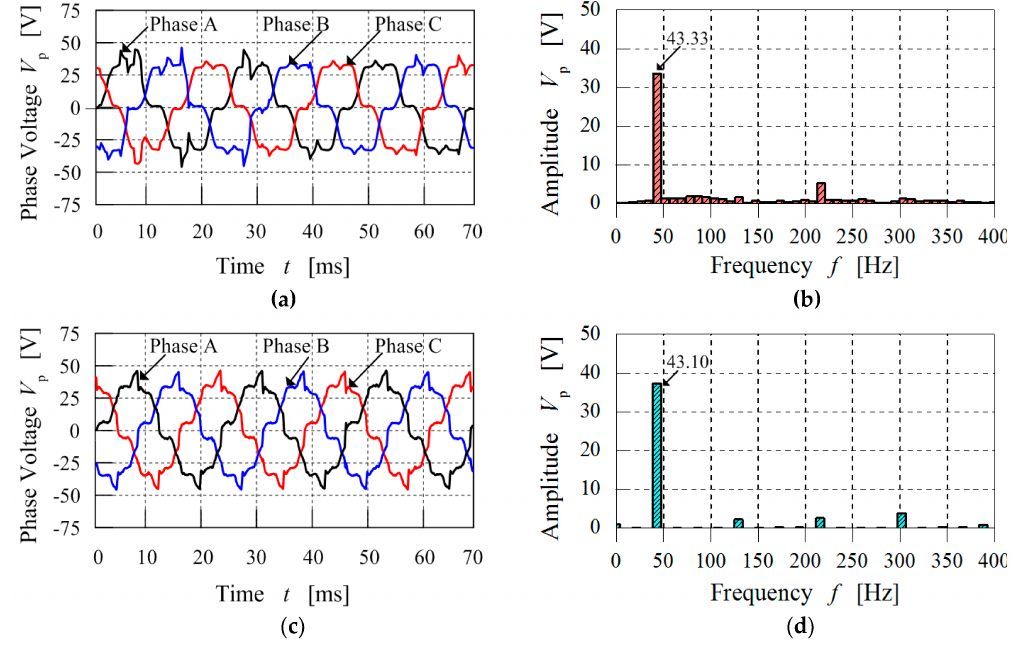
Figure 21. Comparison of output three-phase voltage from generator before DC rectification with load of 100 Ω at prime rotor speed = 200 rpm: ( a ) Simulated three-phase voltage waveform; ( b ) Spectrum analysis of ( a ); ( c ) Measured three-phase voltage waveform; ( d ) Spectrum analysis of ( c